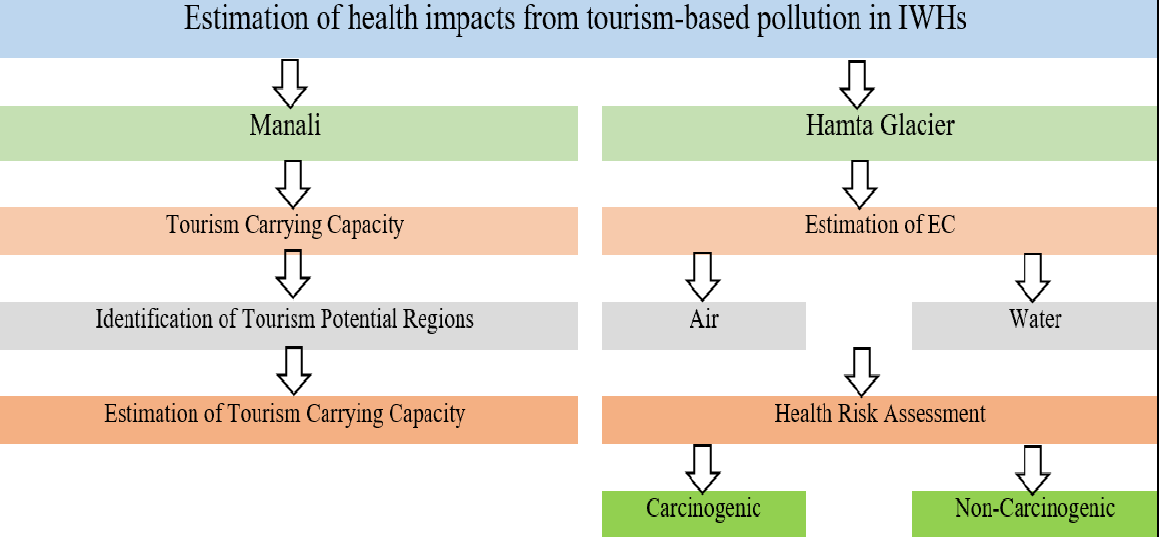
Figure 4. Brief methodology adopted during the study.